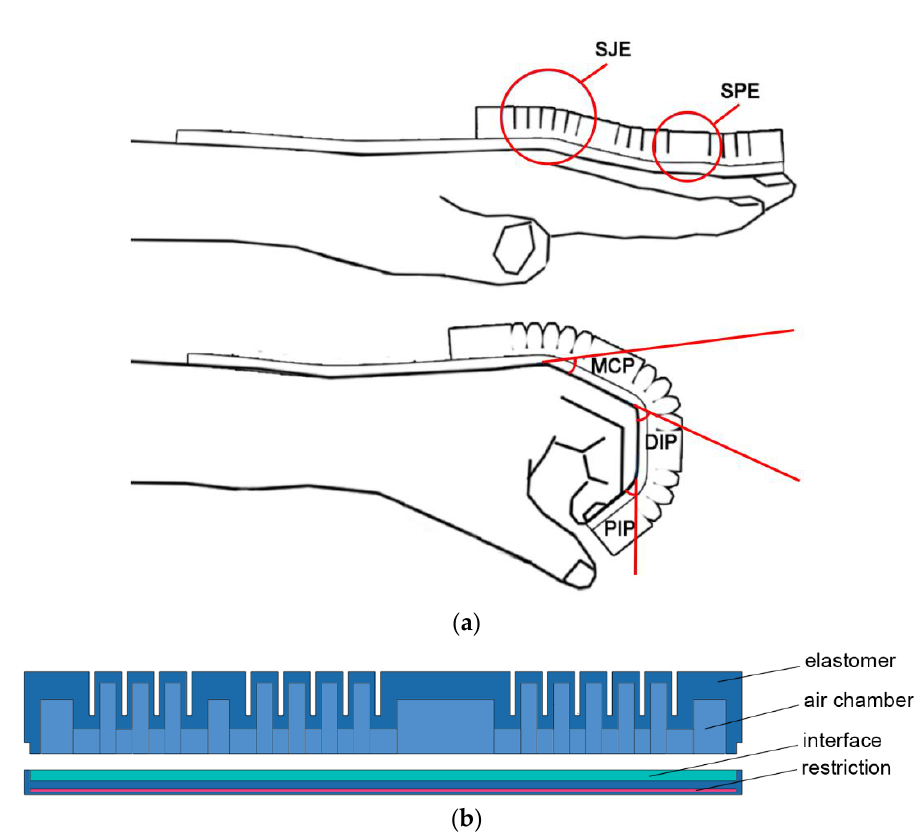
Figure 8. The design for the actuator. ( a ) The design reason for the actuator. ( b ) The detail of the structure for the actuator.